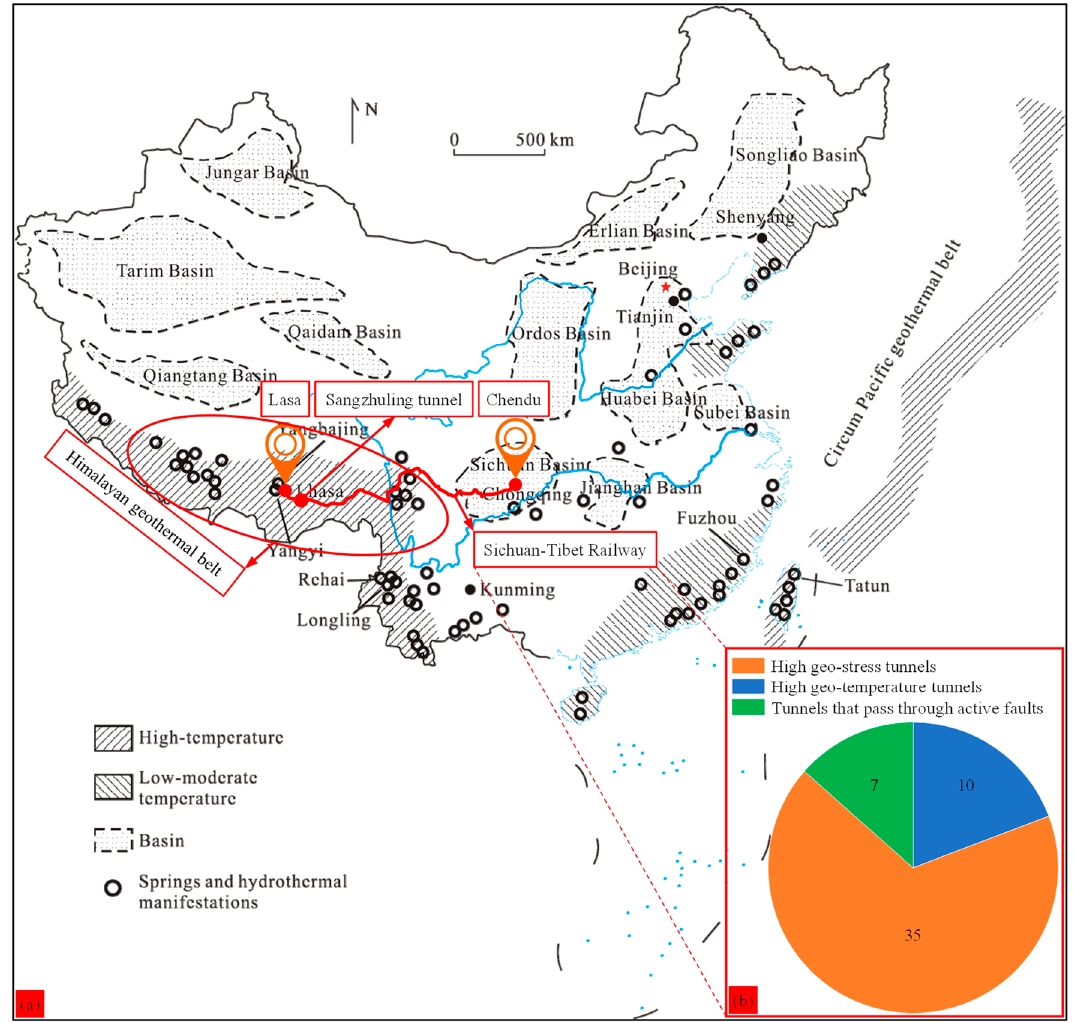
Figure 5. The Himalayan geothermal belt: ( a ) the distribution of geothermal resources in China [39]; ( b ) the number of tunnels with high geo-stress, with high geo-temperature, and that pass through active faults.